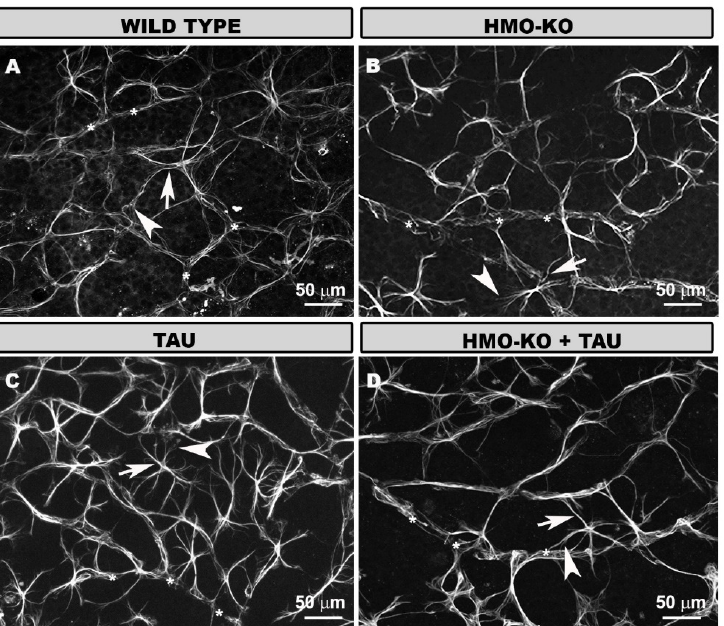
Figure 9. Retinal wholemount. GFAP+ astrocytes in the different study groups: WT ( A ), HMO-KO ( B ), TAU ( C ), HMO-KO+TAU ( D ); 20× magnification. Arrows point to primary astrocyte processes; arrowheads point to secondary astrocyte processes. Asterisks (*) demarcate the course of blood vessels. Number of retinas used in the experiment: WT n = 6, HMO-KO n = 6, TAU n = 6, and HMO-KO+TAU n =